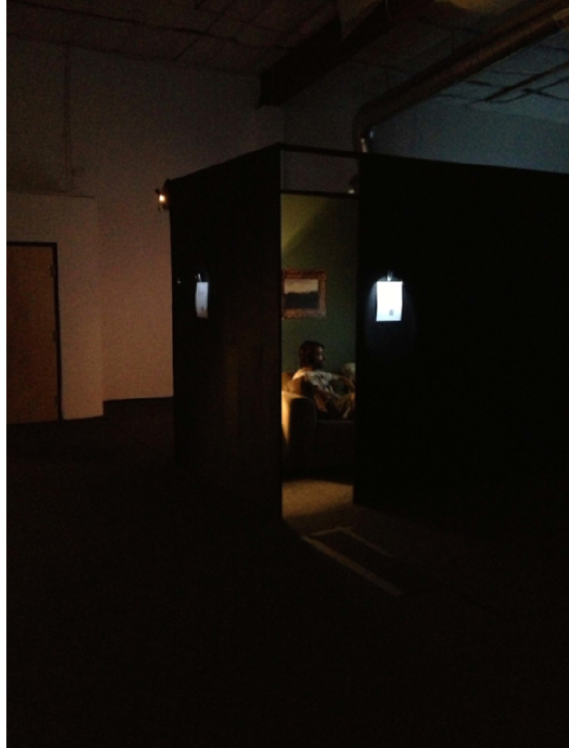
Figure 6. Installation photo from Psychasthenia 2 web- site . Courtesy of the